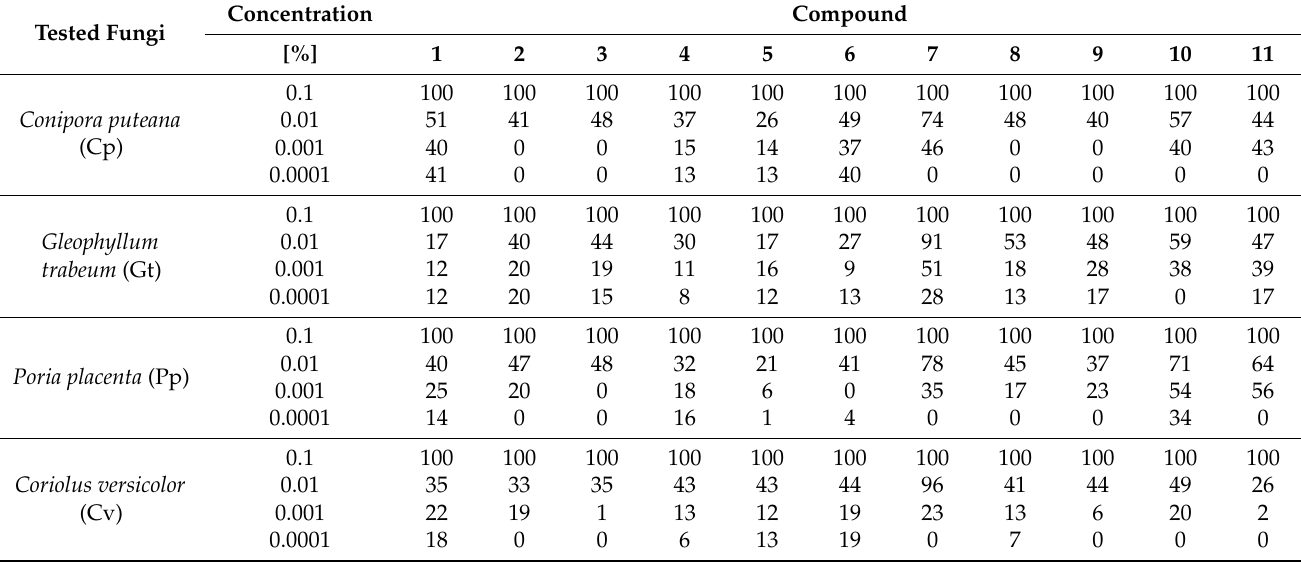
Table 4. Antifungal activity of compounds 1 – 11